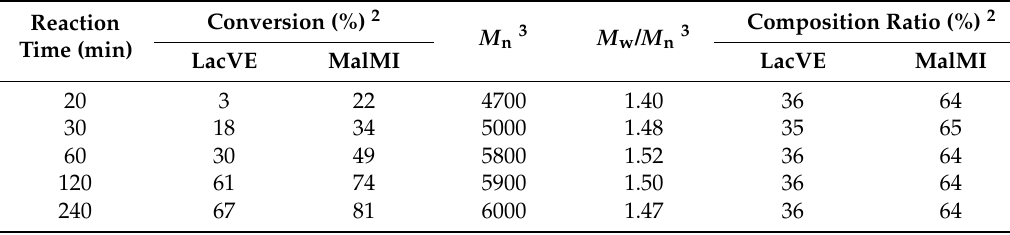
Table 3. RAFT copolymerization of LacVE and MalMI 1